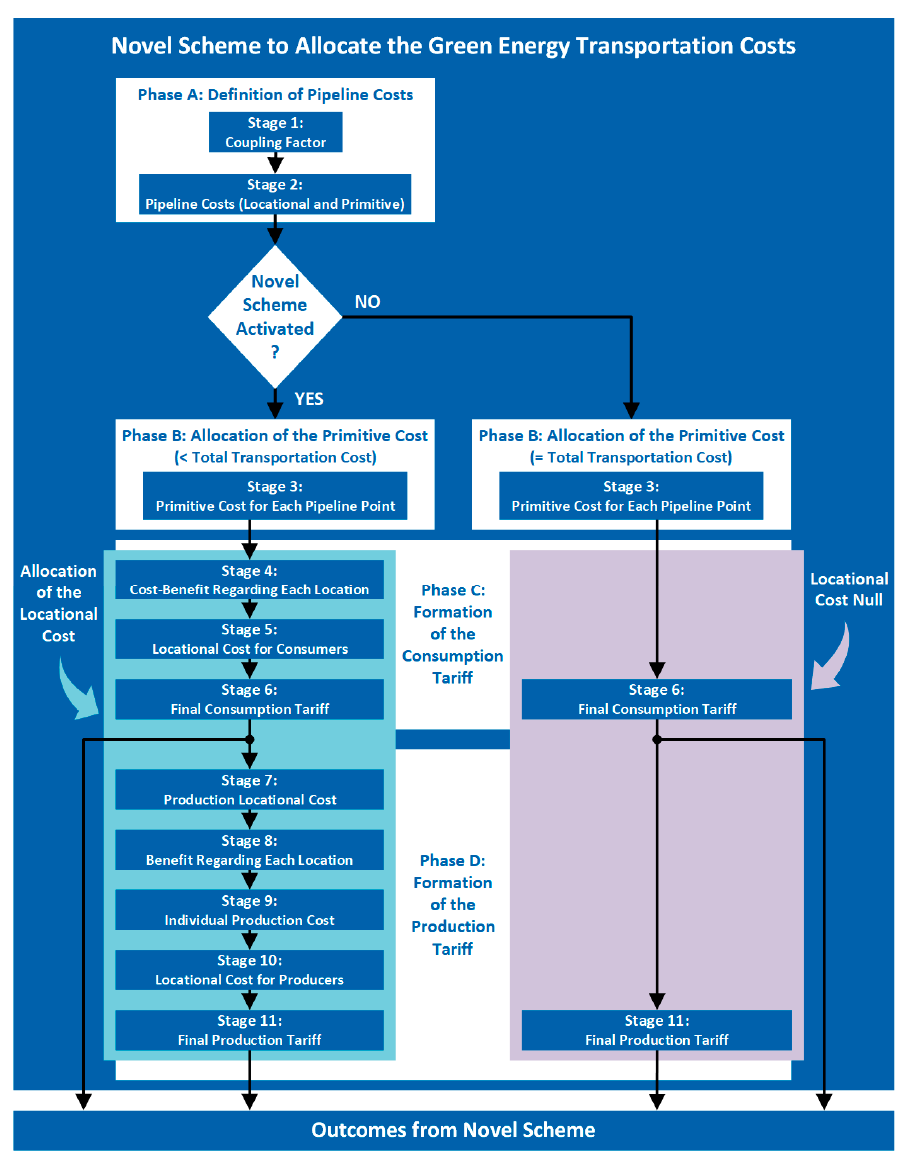
Figure 2. Flowchart of novel scheme for transport cost allocation.